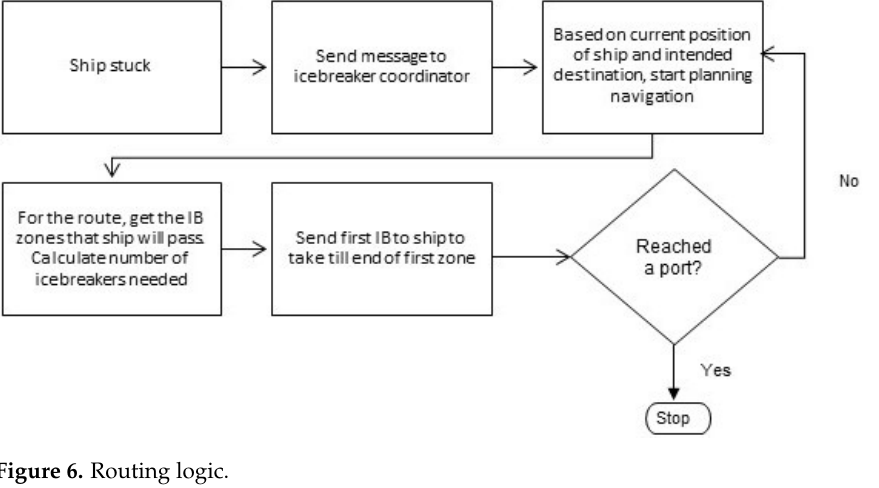
Figure 6. Routing